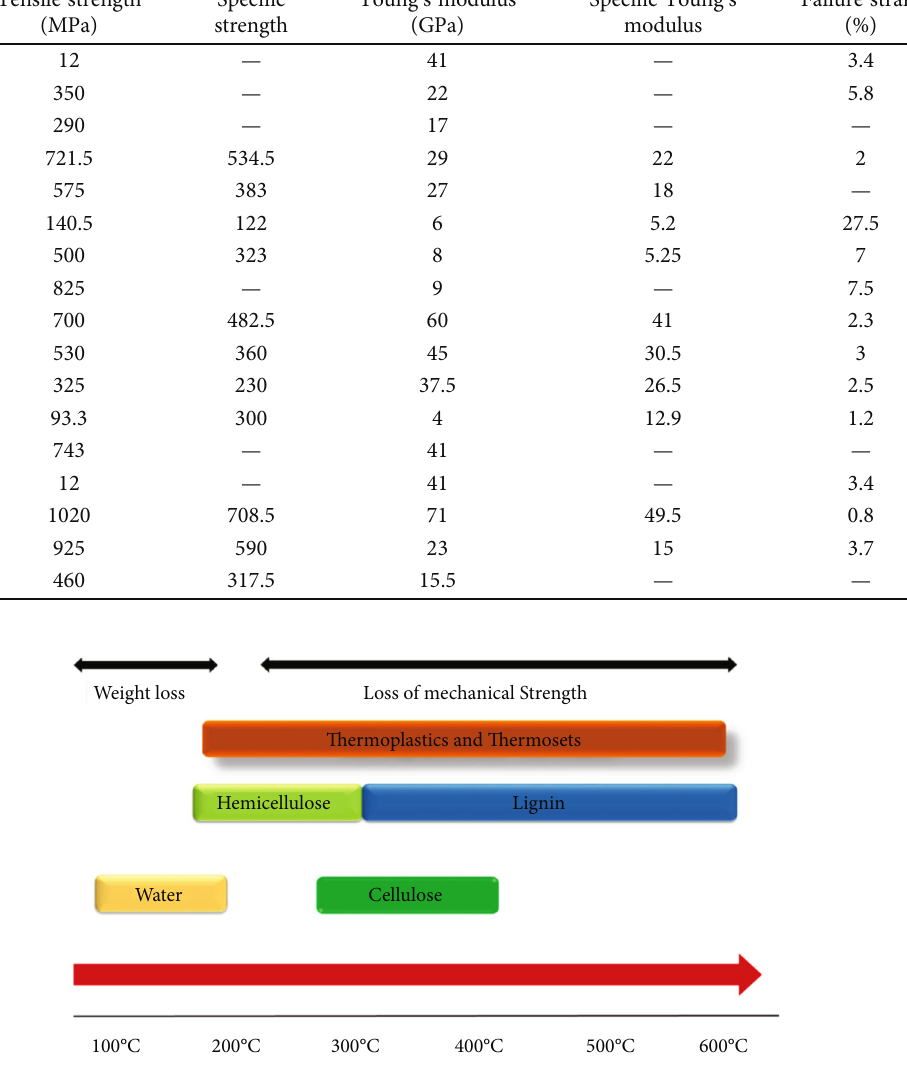
Figure 5: Degradation stages and their in fl uences in